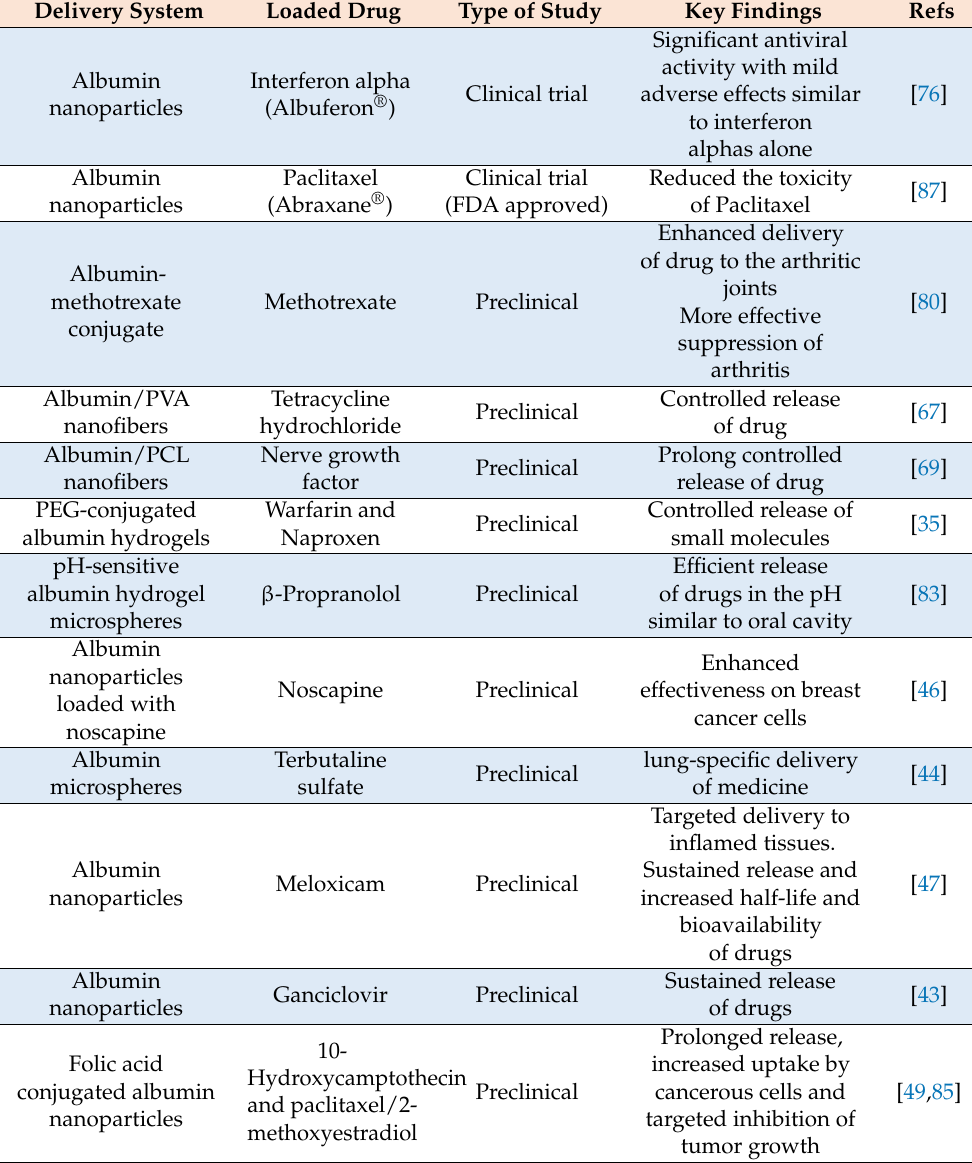
Table 1. Application of albumin in drug